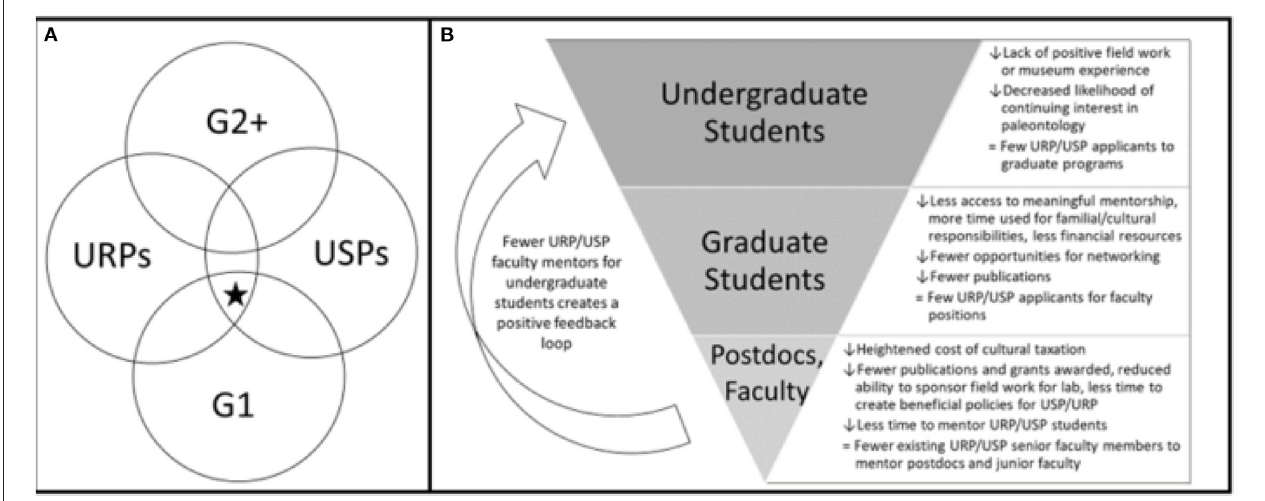
FIGURE 2 | (A) Intersectionality demonstrates the importance of considering all aspects of a person’s identity when aiming to increase accessibility. G1 refers to students who come from families with no previous university experience (i.e., first-generation college students) (this perspective). G2+ refers to students from families with previous university experience (i.e., second-generation and beyond). Note that this notation avoids the positive bias associated with referring to G2+ students as “traditional” students (this perspective). URPs refers to Underrepresented Persons, those that comprise a smaller percentage of students/researchers within a field of interest (e.g., paleontology) than in the general population ( Hamrick, 2021). USPs refers to Underserved Persons, those traditionally disadvantaged compared to other groups because of structural/societal/economic obstacles to educational resources (Short et al., 2020). Star icon represents the intersectional identity of first-generation, underrepresented and underserved scholars. (B) Lack of diversity across higher levels of education reflects the intersection of two factors: attrition rates and devalued/lower metrics of hire-ability. Both factors are results of systemic insufficient support for USP/URPs rather than a passive “leaky pipeline.” Inaction on the part of the field perpetuates the active suppression of diverse